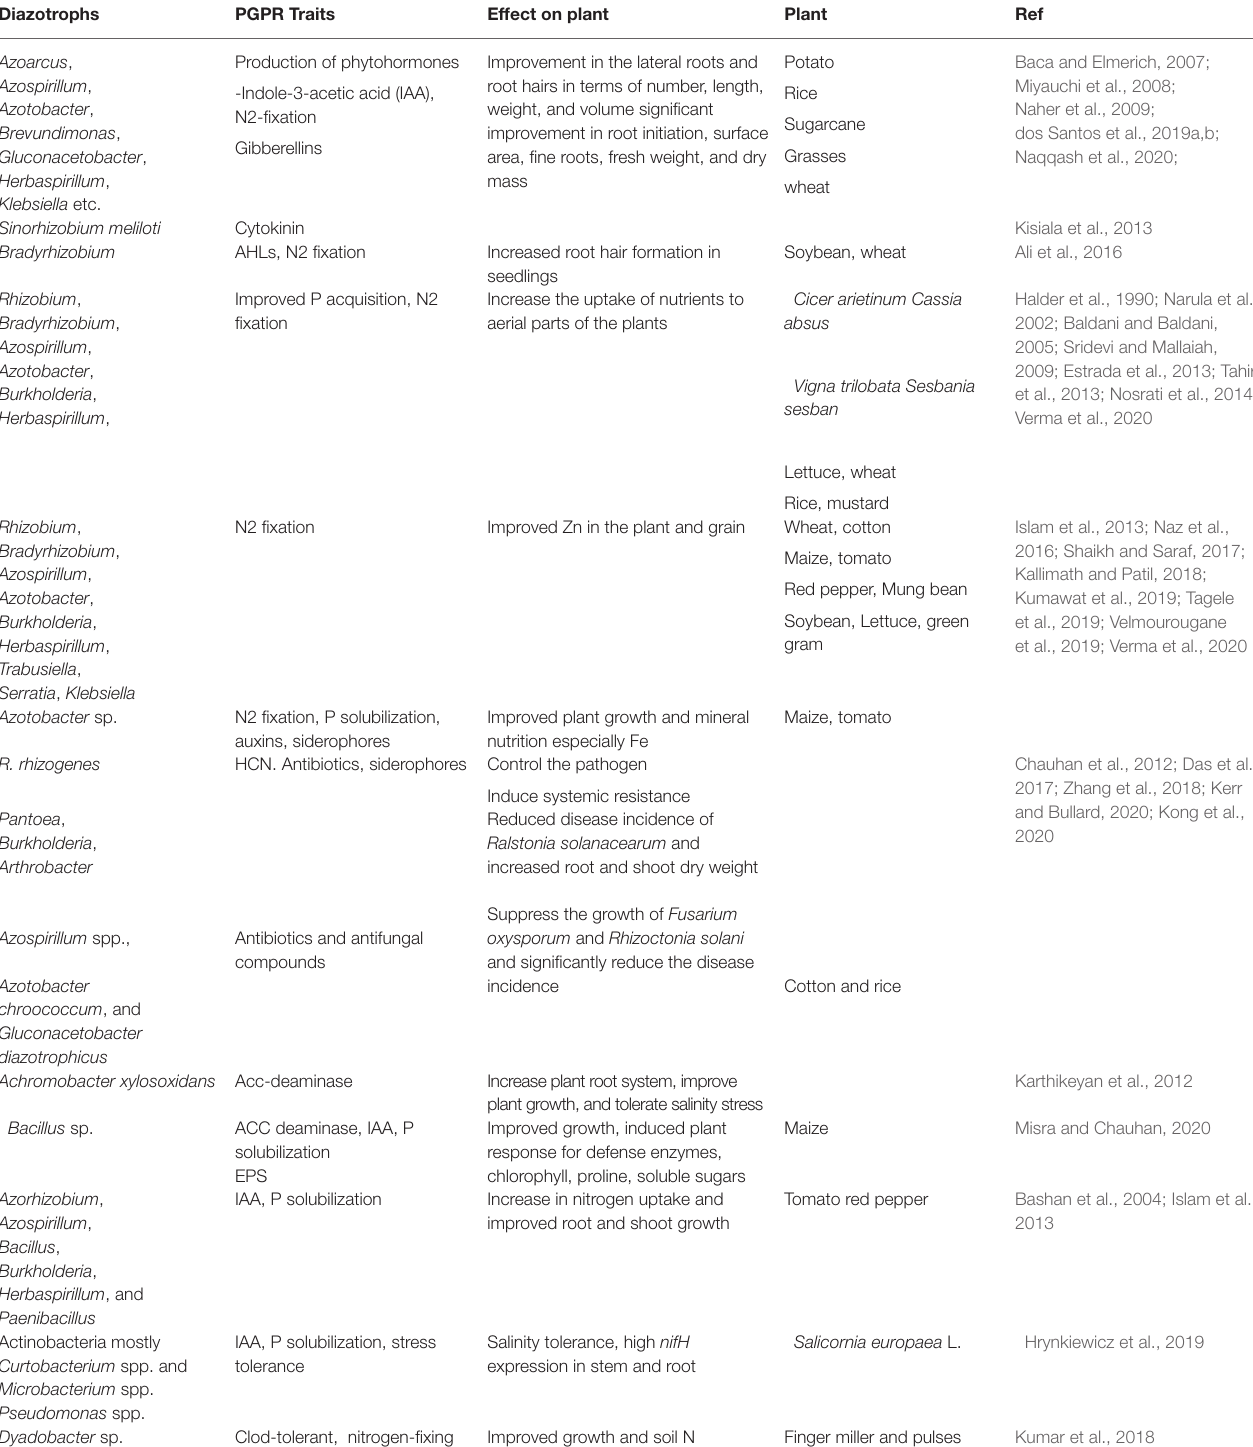
TABLE 2 | List of few diazotrophs with multi-trait characters important for the regulation of BNF and plant growth during